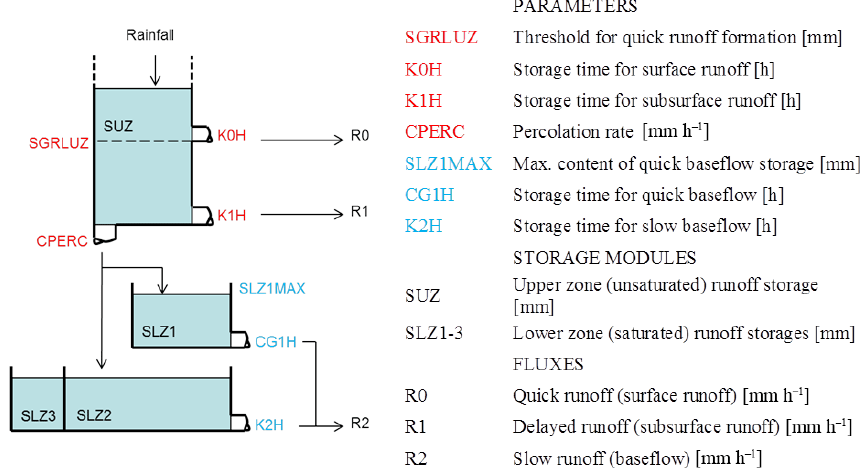
Figure 5. Runoff generation module of PREVAH, adapted from Viviroli et al. (2009b). Parameters in blue are averaged for the whole catchment, while parameters in red are adapted stepwise to the